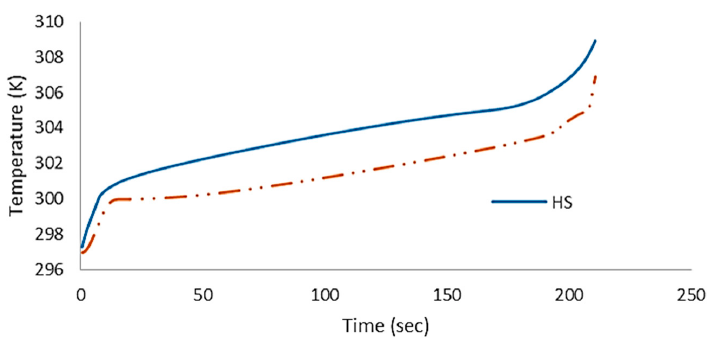
Figure 11. Variation of the temperature of the heat sink and PCM under a heat flux of 5000 W/m 2 .